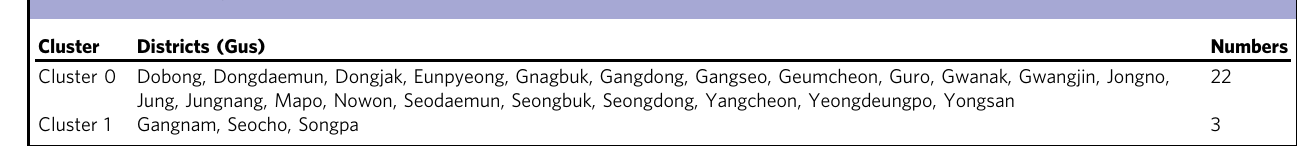
Table 2 Districts by cluster (Seoul). Cluster Districts (Gus) Numbers